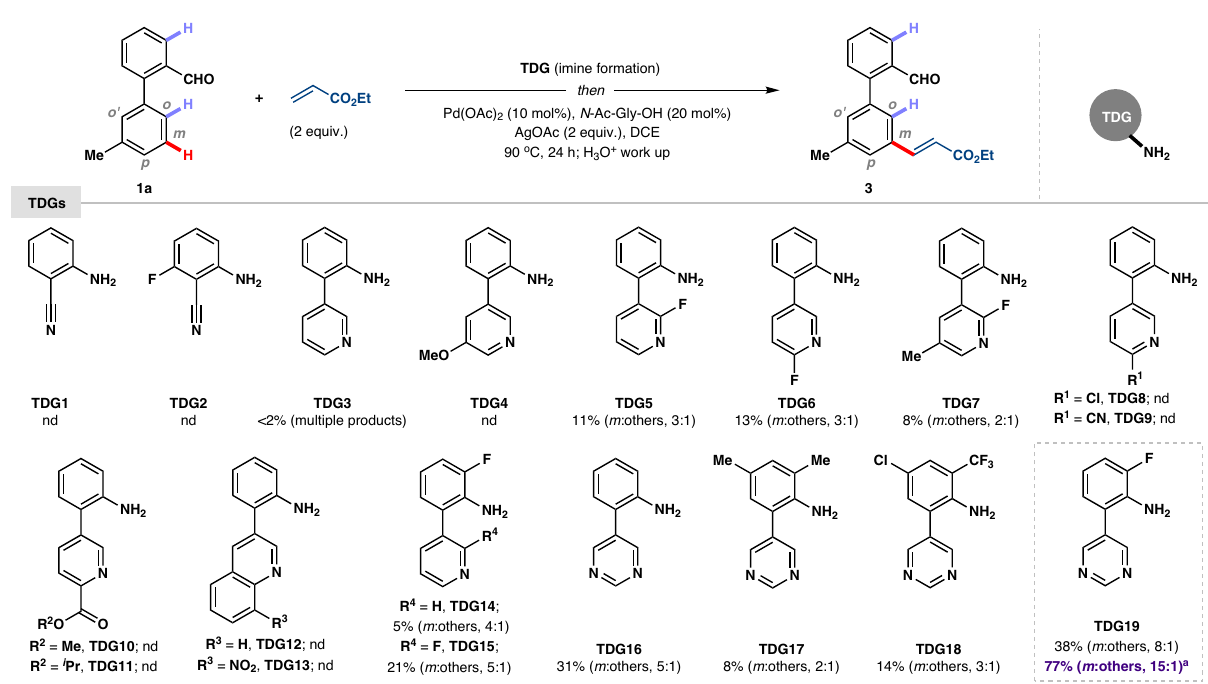
Fig. 2 TDG evaluation for meta -C – H functionalization of biphenyl aldehyde. Imine formation: 1a (0.2 mmol) and TDG (0.2 mmol) in i PrOH (2 mL) at 80 °C for 2 h; Ole fi nation: Pd(OAc) 2 (10 mol%), N -Ac-Gly-OH (20 mol%), AgOAc (2 equiv.) and ethyl acrylate (2 equiv.) in 1,2-dichloroethane (DCE, 2 mL) at 90 °C for 24 h. a Imine formation: 1a (0.2 mmol) and TDG19 (0.19 mmol) in i PrOH (2 mL) at 80 °C for 2 h; Ole fi nation: Pd(OAc) 2 (10 mol%), N -Form-Gly-OH (20 mol%), Ag 2 CO 3 (25 mol%), Cu(OAc) 2 (3.5 equiv.) and ethyl acrylate (3 equiv.) in DCE (2 mL) at 100 °C for 24 h. Ratios of others were shown in parenthesis; nd, not